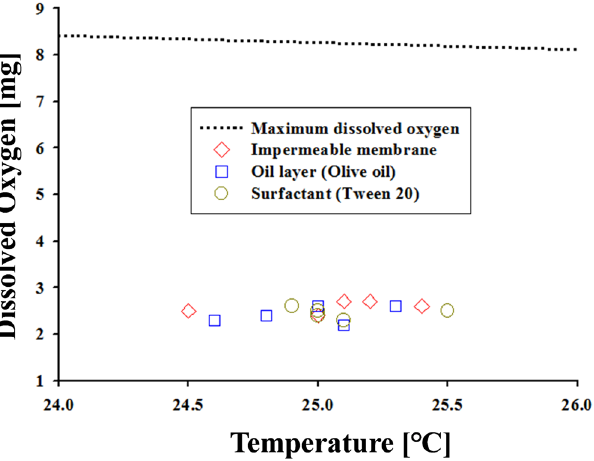
Figure 3. Variations of dissolved oxygen measured after all mosquito larvae are dead. The dashed line indicates the theoretical maximum dissolved oxygen per 1  .